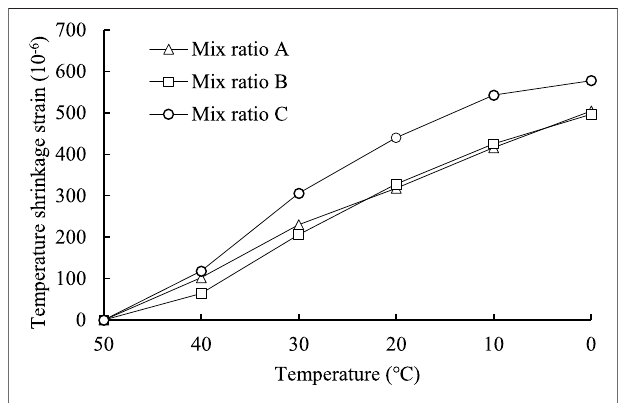
FIGURE 8 | Relationship between shrinkage strain and